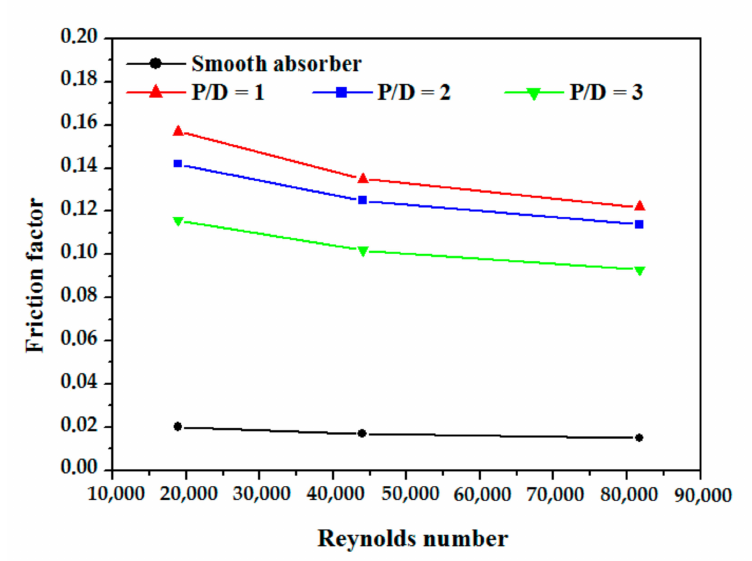
Figure 12. Friction factor variation vs. Re number at different obstacle